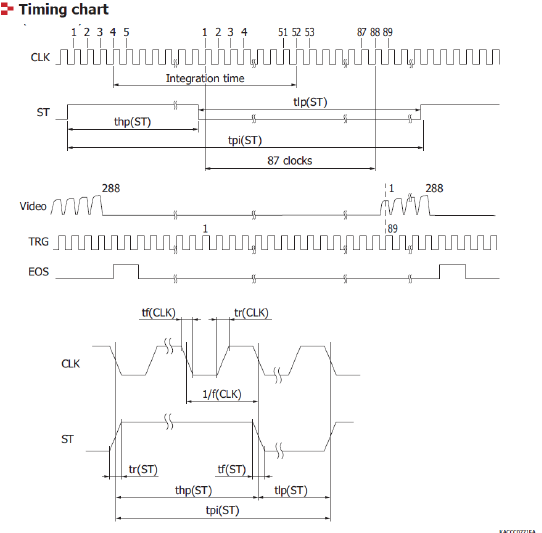
Figure A2. Timing chart for signal input and output for micro-spectrometer Hamamatsu C12880MA